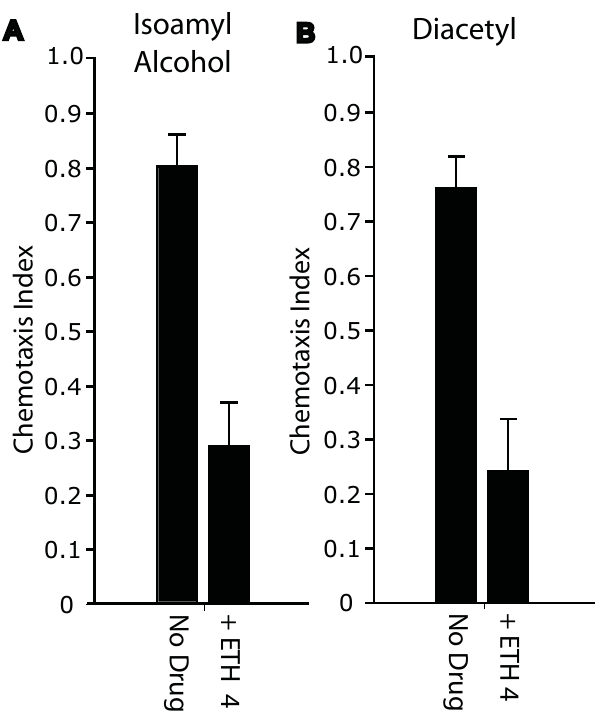
Figure 6. Ethosuximide disrupted chemotaxis toward the volatile attractants isoamyl alcohol and diacetyl. Wild-type animals grown from conception to adulthood on NGM plates containing 2 mg/ml ethosuximide or no drug were transferred to the center of a 10 cM chemotaxis plate containing 4 mg/ml of ethosuxi- mide or no drug, respectively. A chemotaxis index (CI) to isoamyl alcohol or diacetyl was determined. (A) Chemotaxis to isoamyl alcohol. The mean CI 6 SD for untreated and ethosuximide treated animals was 0.8 6 0.2 and 0.3 6 0.2, respectively (p , 0.0001, n=8) (Student T-test). (B) Chemotaxis to diacetyl. The mean CI 6 SD for untreated and ethosux- imide treated animals was 0.8 6 0.14 and 0.2 6 0.2, respectively (p=0.0009, n=6) (Student T-test). Error bars represent standard error of mean.